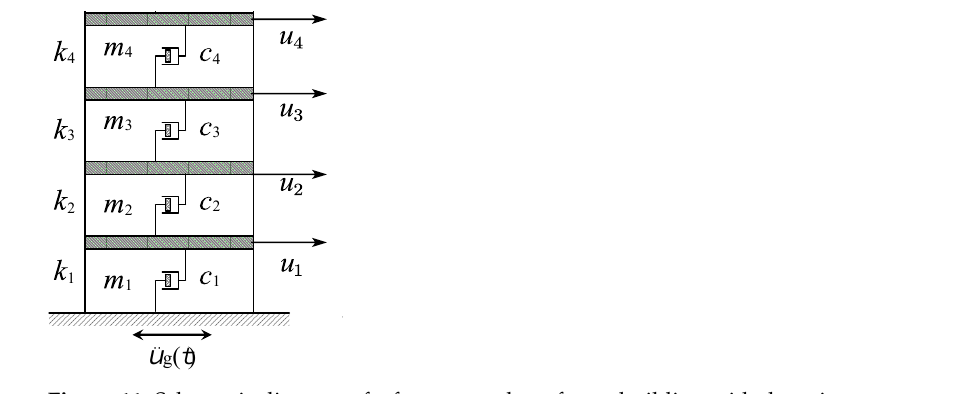
Figure 11. Schematic diagram of a four-story shear frame building with damping. The system is subjected to the ground acceleration record of the El Centro wave, where the peak ground acceleration (PGA) is scaled to 0.5 g. The sampling interval of the record is 0.02 s. The time history and response spectrum of the El Centro wave are shown in Figure 12, noting that the peak frequency of the response spectrum ω p = 24.166 rad/s.